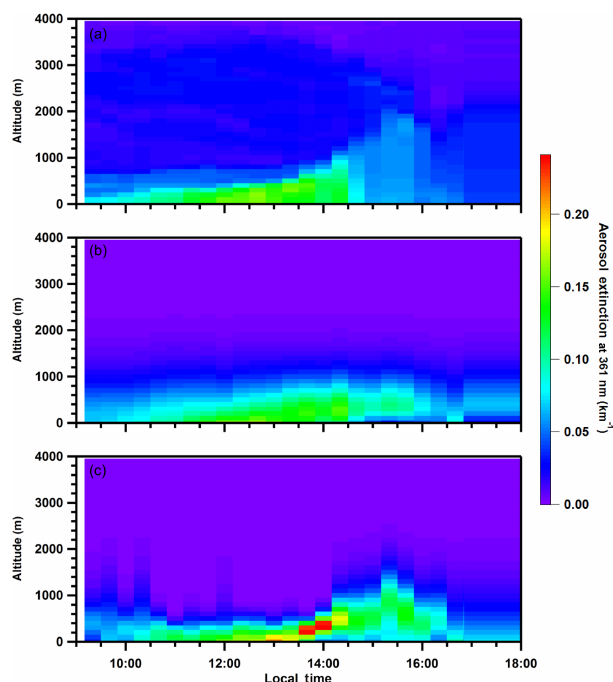
Figure 15. The 4 September vertical profiles of aerosol extinction (361nm) from averaged lidar (a) , smoothed lidar (b) , and MAX- DOAS retrieved measurements (c) .